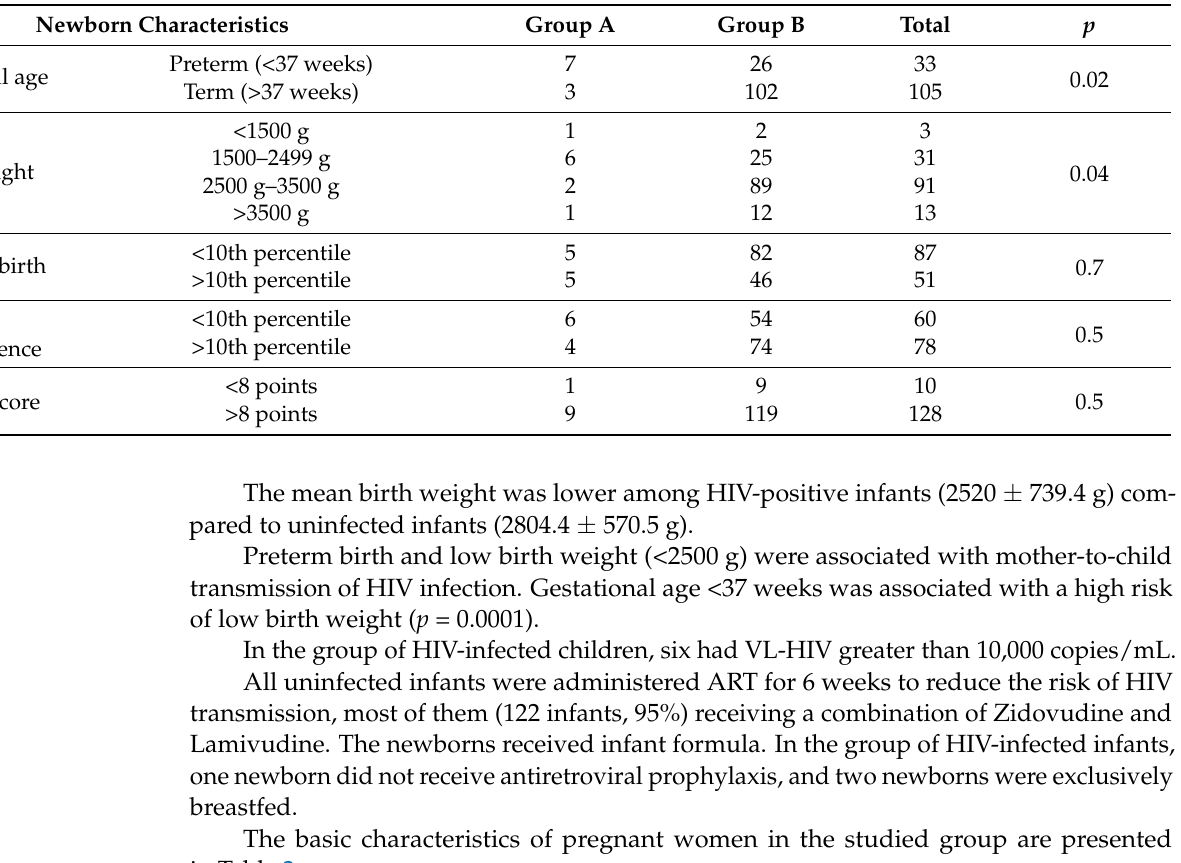
Table 2. Basic characteristics of pregnant women living with HIV.